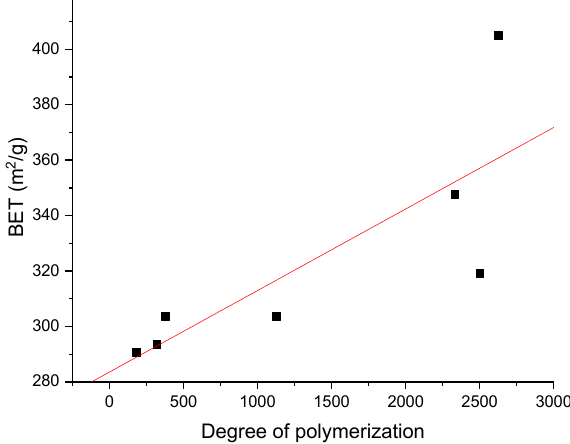
Figure 7. Brunauer–Emmett–Teller (BET) specific surface area of cellulose aerogels as a function of the DP.